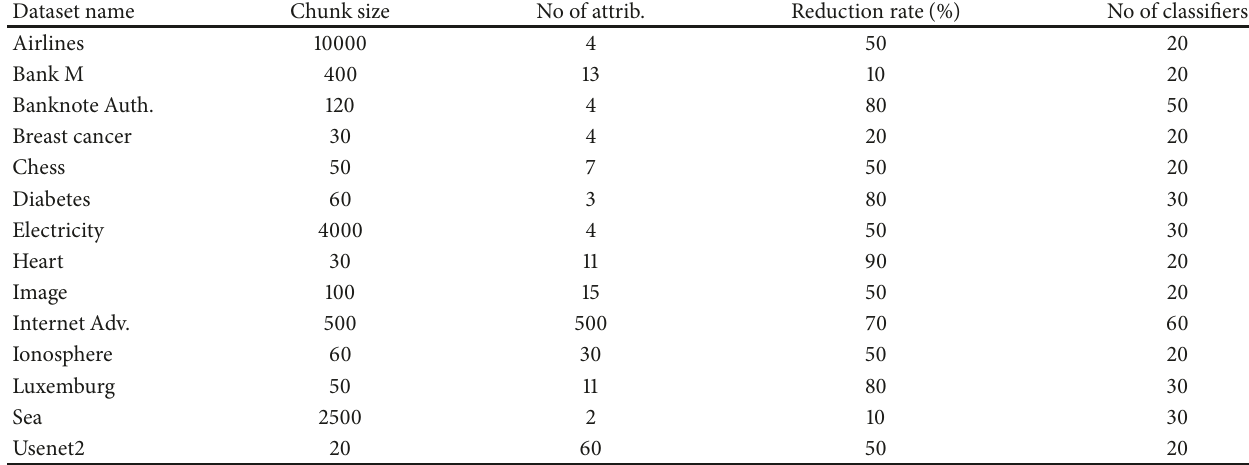
Table 2: Experiment settings for algorithms Inc-GEP2 and Inc-GEP3.